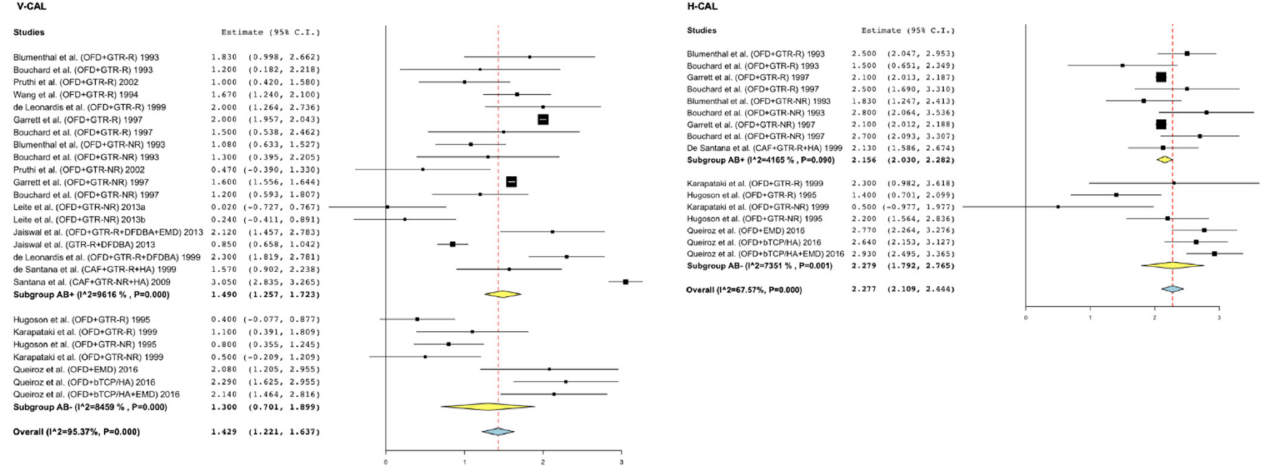
Figure 4. Forest plots of single-arm meta-analyses for V-CAL and H-CAL gain for studies of regener- ative techniques in furcation defects with or without adjunctive